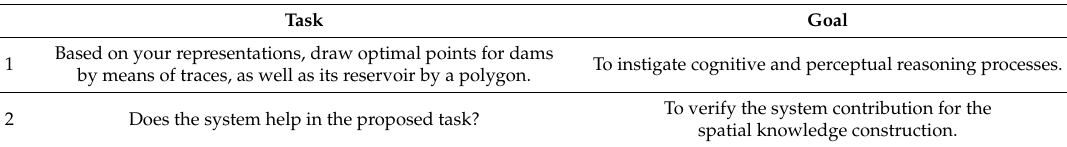
Table 4. Third Stage Tasks.